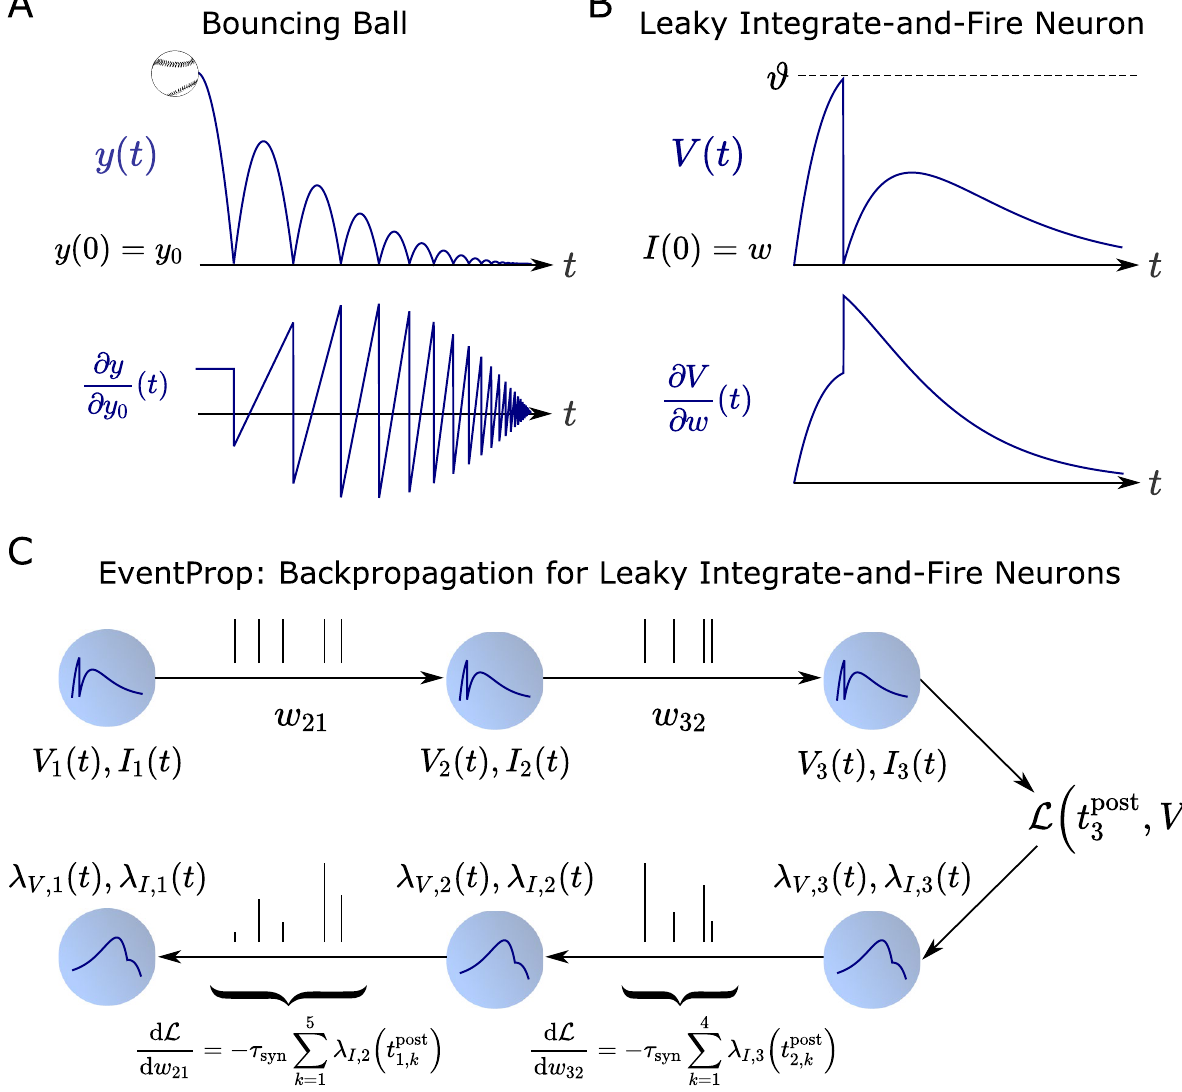
Figure 1. We derive the precise analogue to backpropagation for spiking neural networks by applying the adjoint method together with the jump conditions for partial derivatives at state discontinuities, yielding exact gradients with respect to loss functions based on membrane potentials or spike times. ( A, B ) Dynamical systems with parameter-dependent discontinuous state transitions typically have discontinuous partial derivatives of state variables with respect to system parameters 4 , as is the case for the two examples shown here. Both examples model dynamics occurring on short timescales, namely inelastic reflection and the neuronal spike mechanism, using an instantaneous state transition. We denote quantities evaluated before and after a given transition by − and + . In A, a bouncing ball starts at height y 0 > 0 and is described by ¨ y = − g with gravitational acceleration g . It is inelastically reflected as ˙ y + = − 0.8 ˙ y − as soon as y − = 0 holds, causing the partial derivative with respect to + = − 0.8 ∂ y − y 0 to jump as ∂ y ∂ y 0 ∂ y 0 (see first methods subsection). In B, a leaky integrate-and-fire neuron described by the system given in Table 1 with initial conditions I ( 0 ) = w , V ( 0 ) = 0 resets its membrane potential as + ∂ V − ϑ + 1 = V + = 0 when V − = ϑ holds, causing the partial derivative to jump as ∂ V (cid:30) (cid:31) ∂ w ∂ w (see methods τ mem ˙ V − for the full derivation). ( C ) Applying the adjoint method with partial derivative jumps to a network of leaky integrate-and-fire neurons (Table 1) yields the adjoint system (Table 2) that backpropagates errors in time. EventProp is an algorithm (Algorithm 1) returning the gradient of a loss function with respect to synaptic weights by computing this adjoint system. The forward pass computes the state variables V ( t ), I ( t ) and stores spike times t post and each firing neuron’s synaptic current. EventProp then performs the backward pass by computing the adjoint system backwards in time using event-based error backpropagation and gradient accumulation: each time a spike was transferred across a given synaptic weight in the forward pass, EventProp backpropagates the error signal represented by the adjoint variables (cid:31) V ( t post ) , (cid:31) I ( t post ) of the post-synaptic (target) neuron and updates the corresponding component of the gradient by accumulating (cid:31) I ( t post ) , finally yielding sums as given in the